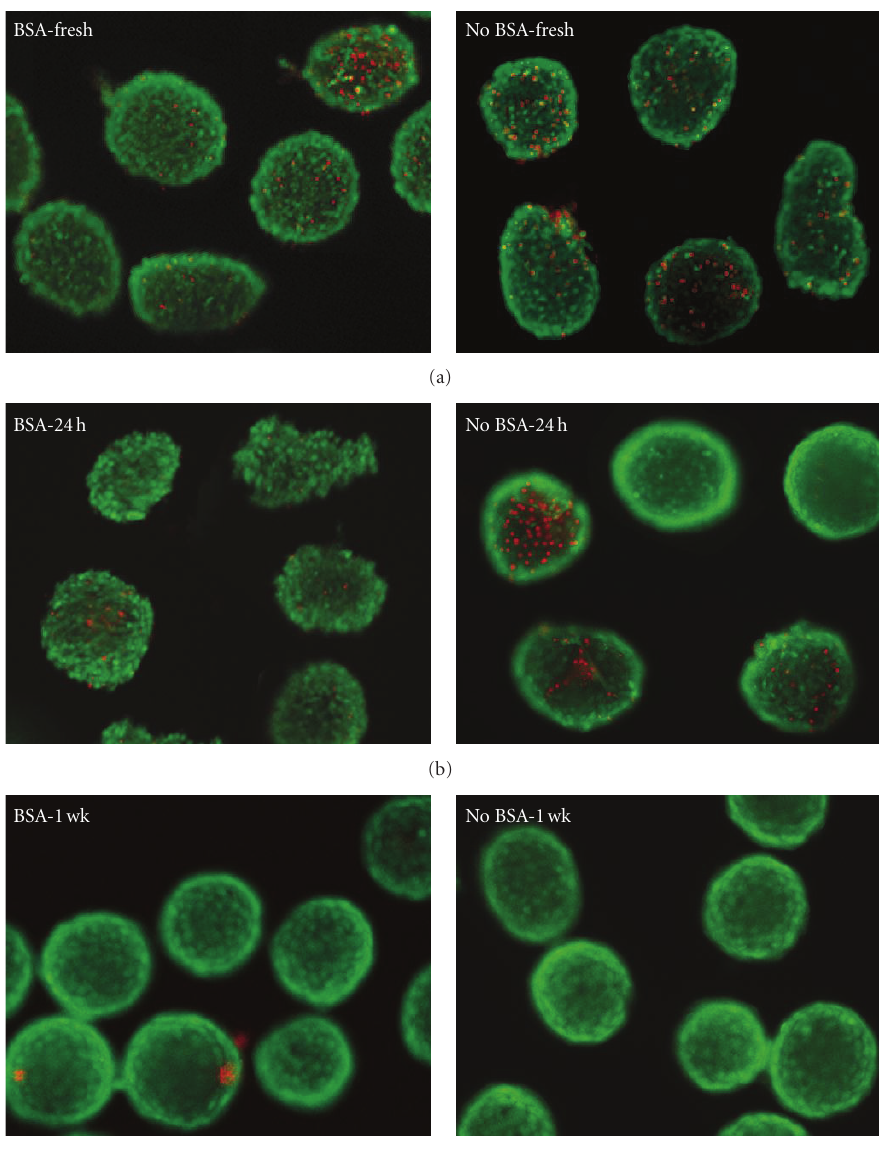
Figure 4: Viability assay using Calcien-AM (green) to indicate live cells and Propidium iodide (red) that stains dead cells. Top panel shows islets stained 1 hour after isolation, middle panel is after 24 hours in culture, and bottom panel is after 1 week in culture. Original magnification